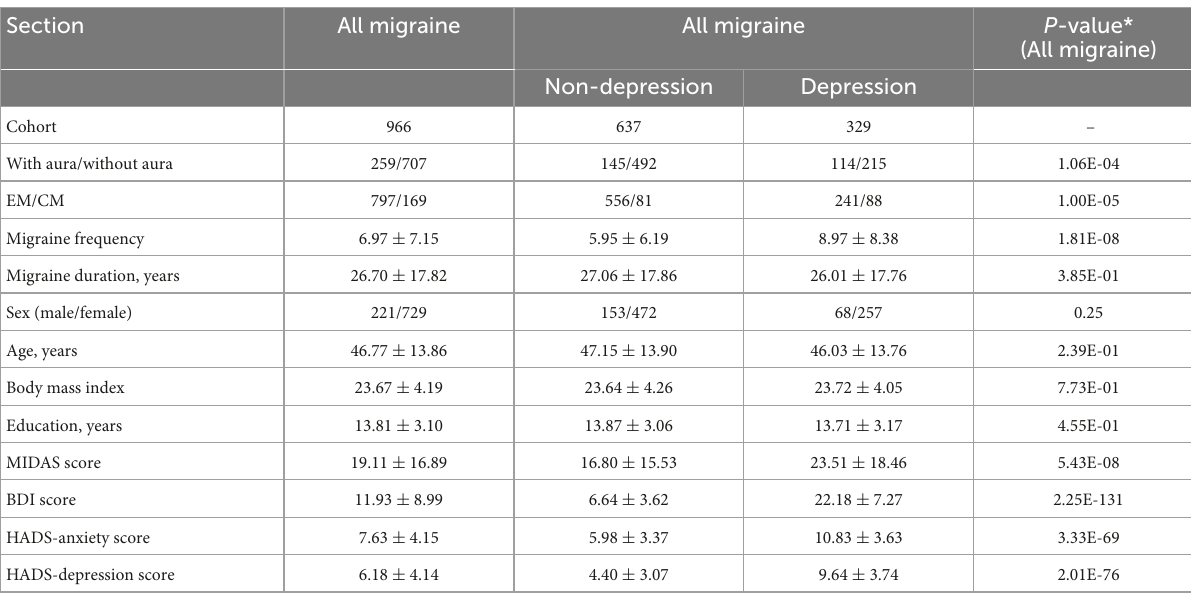
* P -values were calculated using Chi-square test and t -test grouped by depression and non-depression. EM, episodic migraine; CM, chronic migraine; MIDAS, Migraine Disability